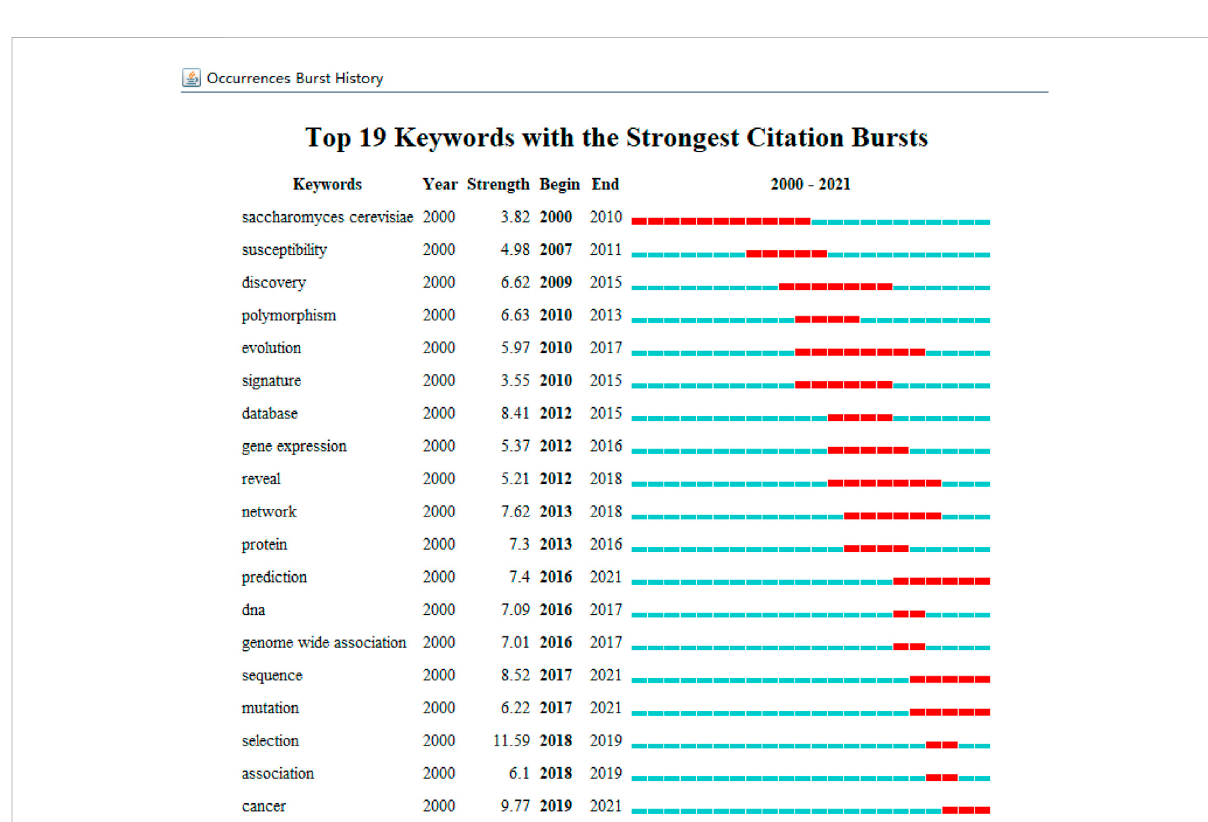
FIGURE 8 Keywords with the strongest citation bursts of publications from 2000 to